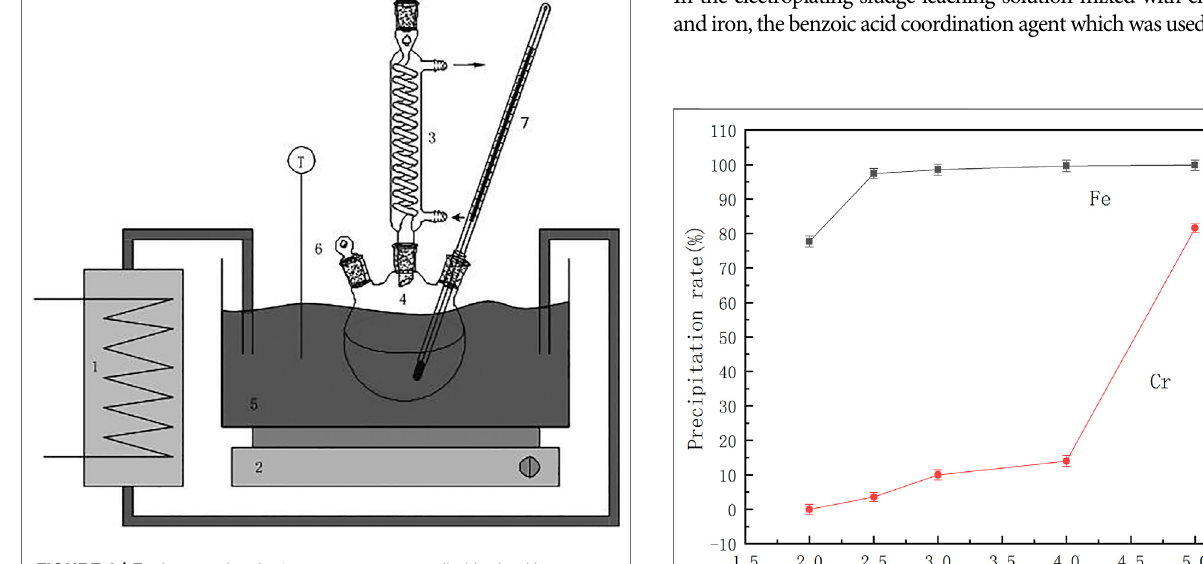
FIGURE 3 | Equipment sketch: 1: temperature-controlled bath with external fl ow; 2: magnetic stirrer; 3: tap water-cooled condenser; 4: round- bottom fl ask with three holes; 5: water bath; 6: outlets for batch addition and solution sampling; 7: thermometer. FIGURE4|